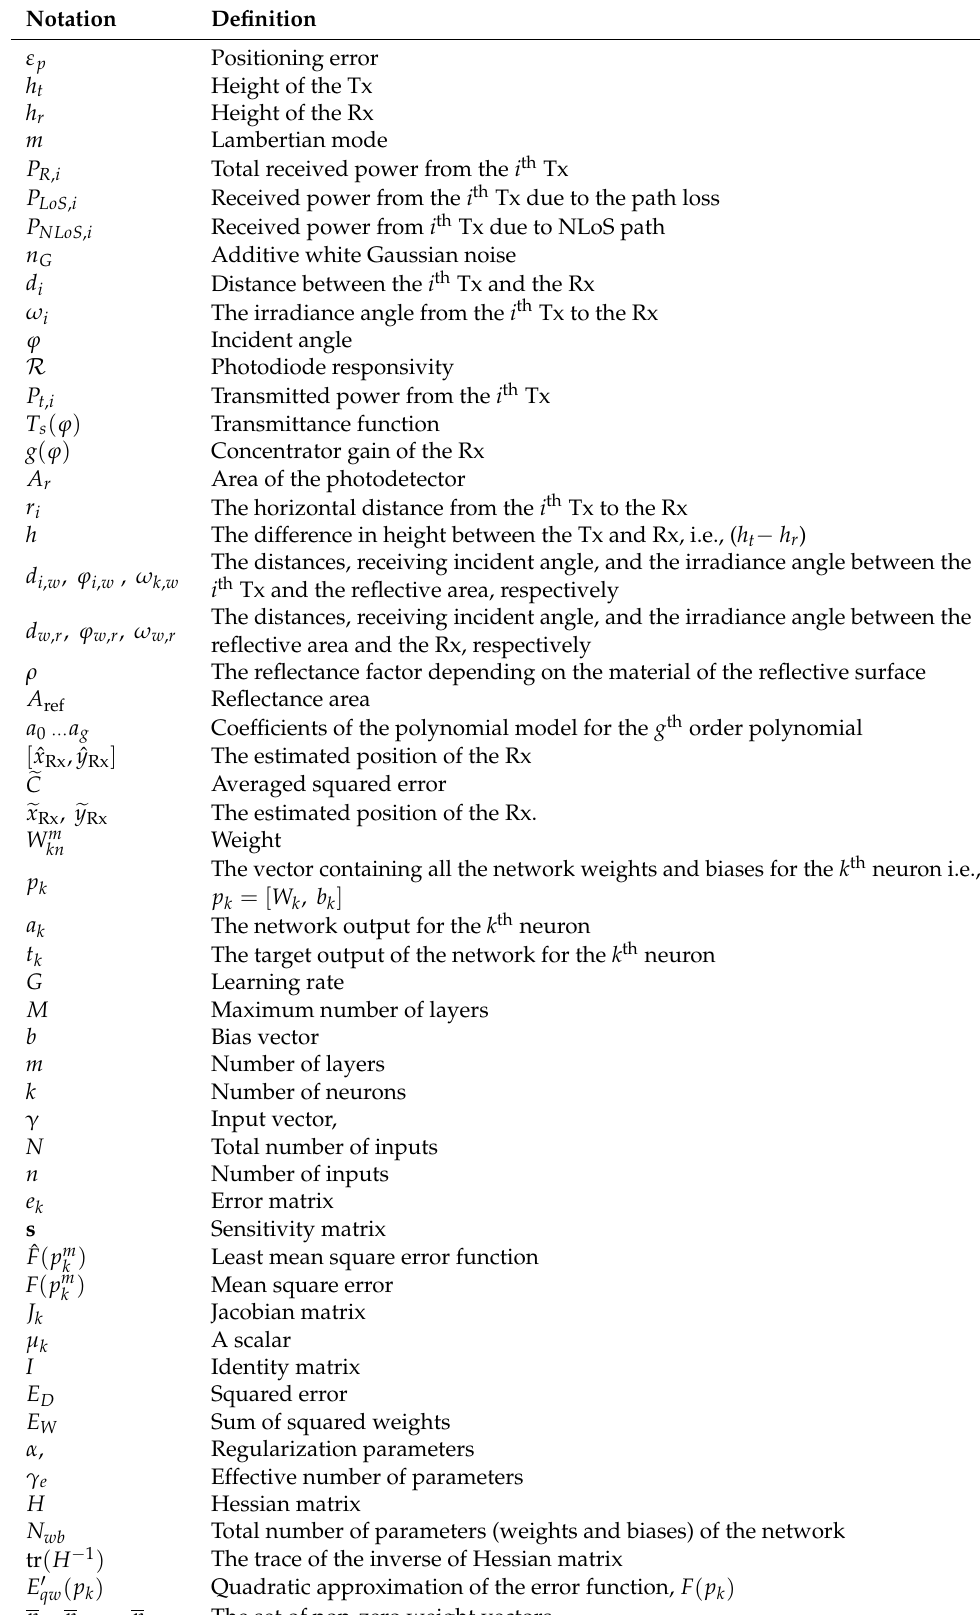
Table 1. List of notations used in this